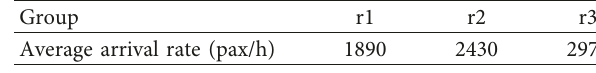
Table 1: Arrival rate of the bus route.